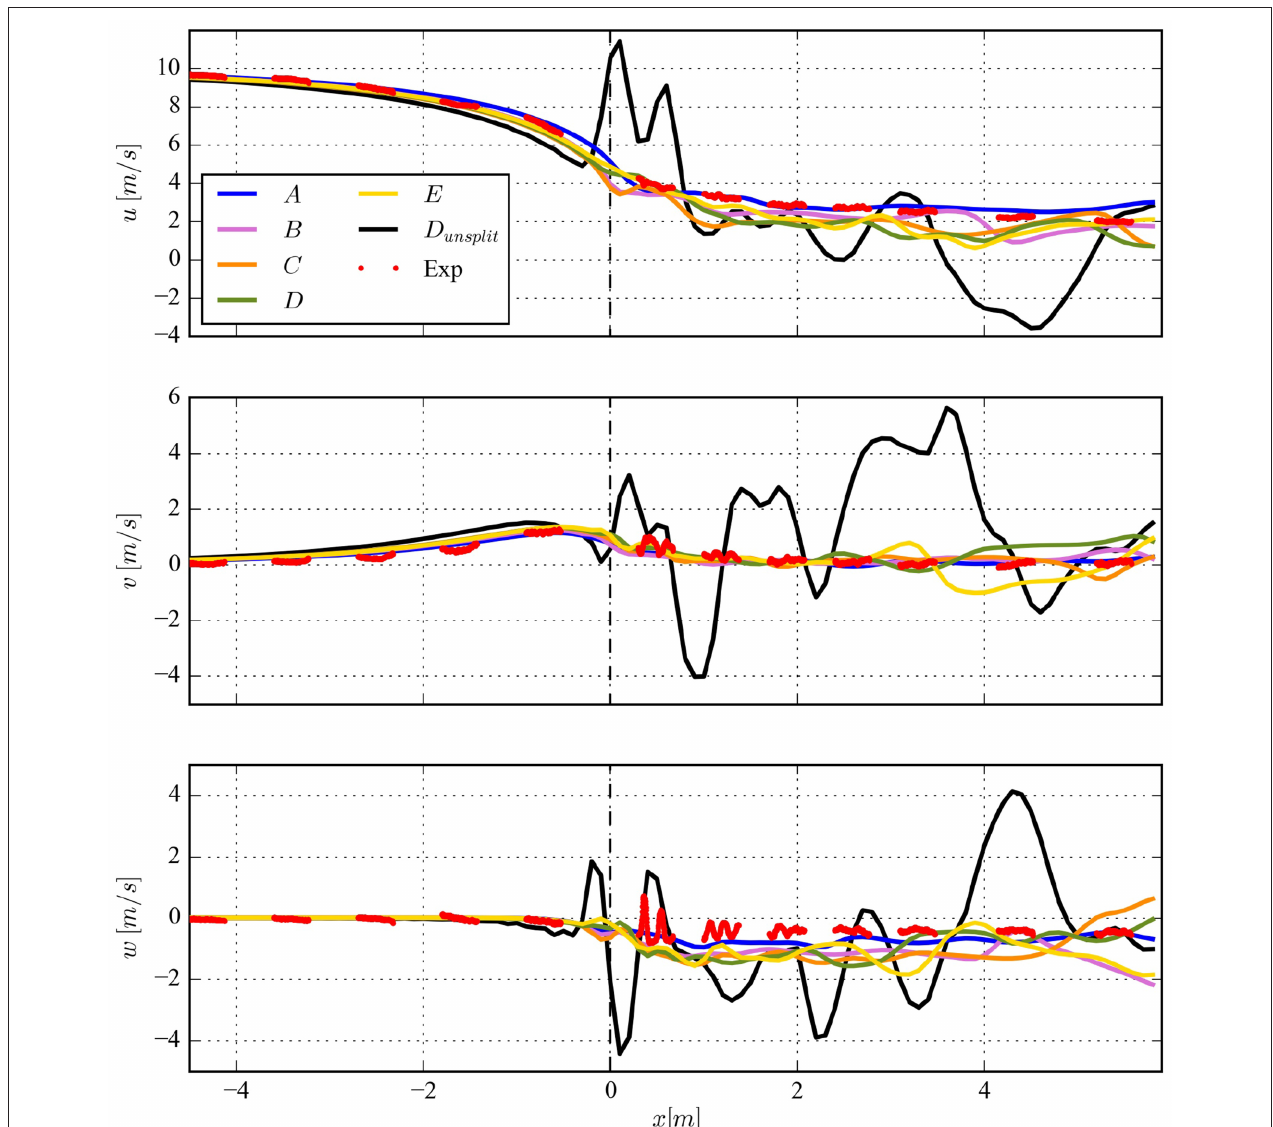
FIGURE 5 | Comparison of axial PIV traverses for the case 10 m/s with the New MEXICO experiment (Boorsma and Schepers, 2014) for different time-splitting